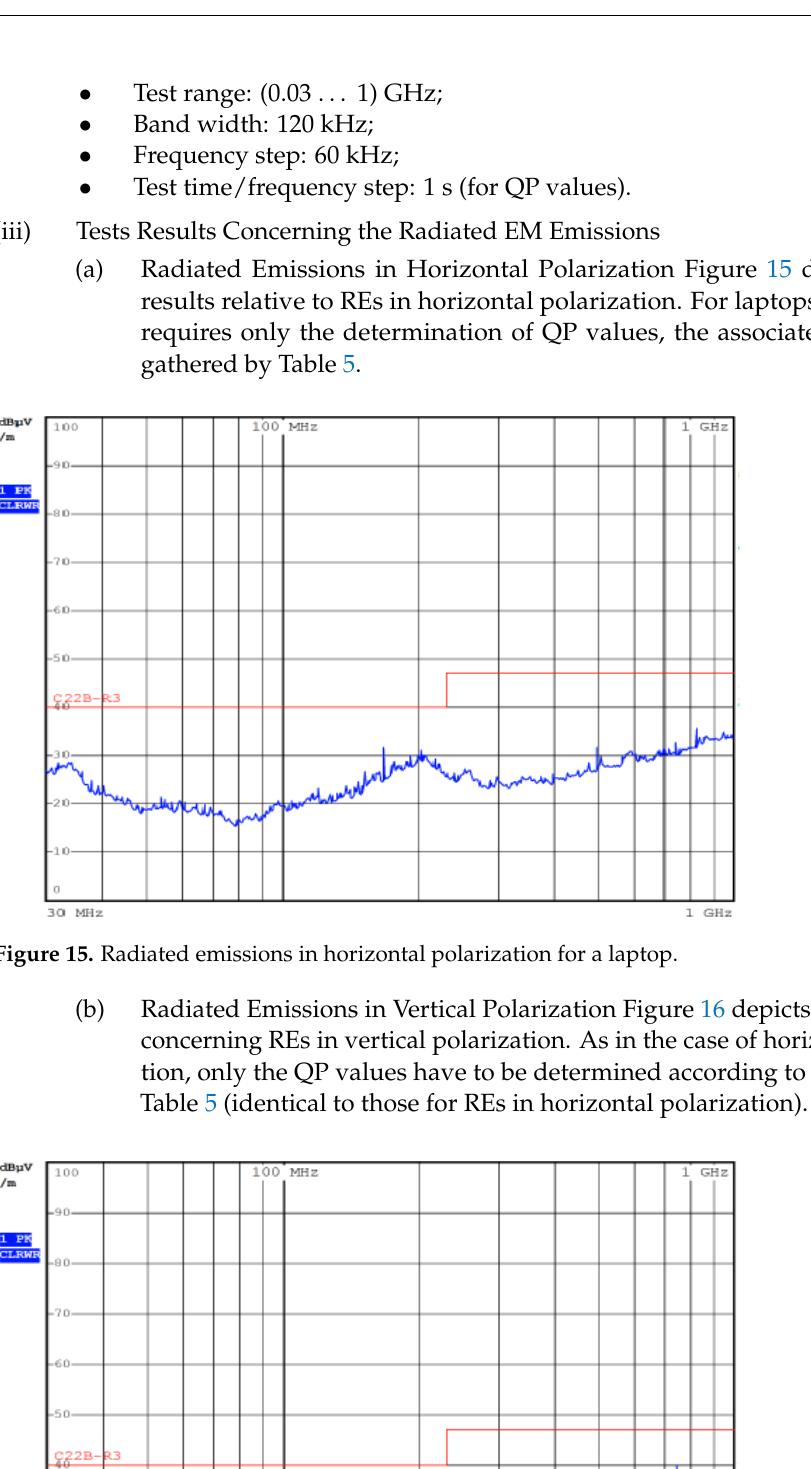
Figure 16. Radiated emissions in vertical polarization for a laptop.